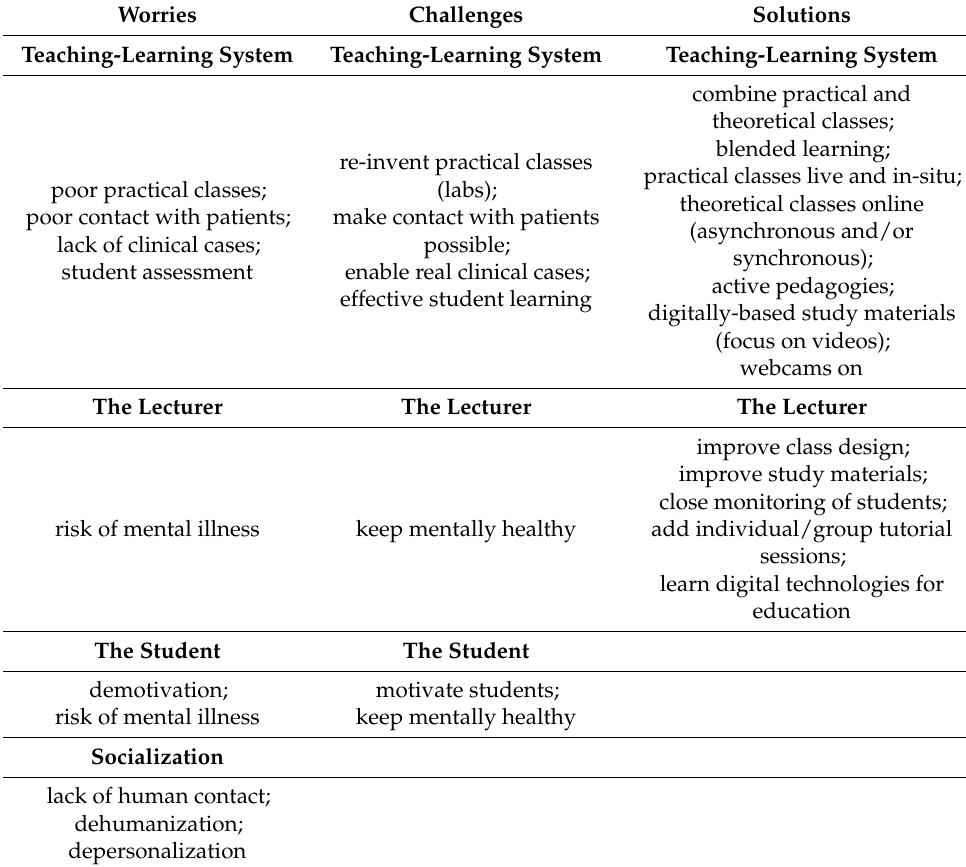
Table 6. Worries, challenges and possible solutions for ERT: results of qualitative